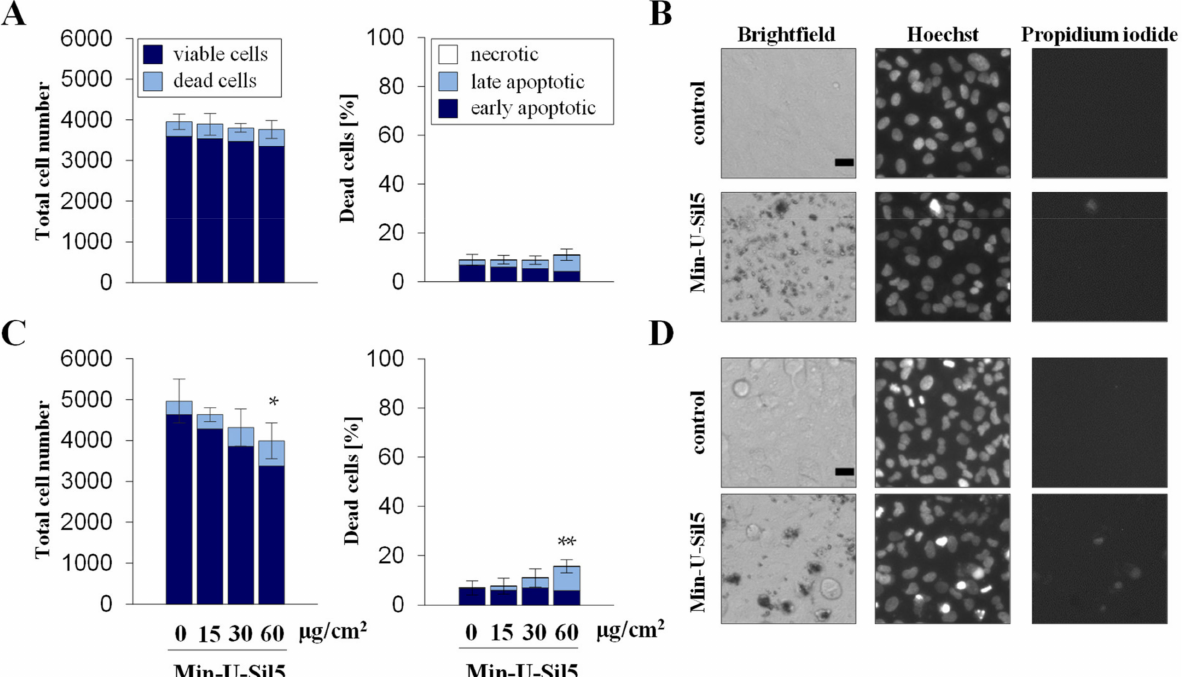
Figure 2. Proliferation and cell death of A549 cells after submerged exposure to Min-U-Sil5 in the absence ( A , B ) or presence of FBS ( C , D ). A549 cells were treated with 0, 15, 30, and 60 µ g/cm 2 Min-U- Sil5 (0, 50, 100, and 200 µ g/mL) for 24 h. The cells were stained with Hoechst and PI and analyzed by automated high-throughput microscopy (AHM). Shown is the total cell number divided into living and dead cells and the percentage of dead cells ( A , C ) relative to the total cell number divided into apoptotic (condensed chromatin), late apoptotic (condensed chromatin + PI-positive), and